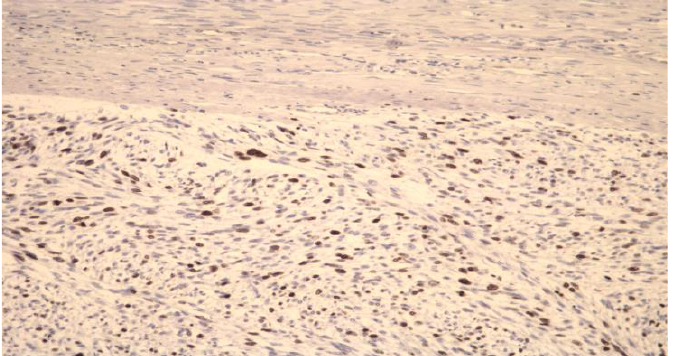
Figure 1. Immunohistochemical preparation of LMS cells (magnification at 10×). It could be seen that the tumor is heterogeneous. The tumor cells frequently express Ki-67 antigen.